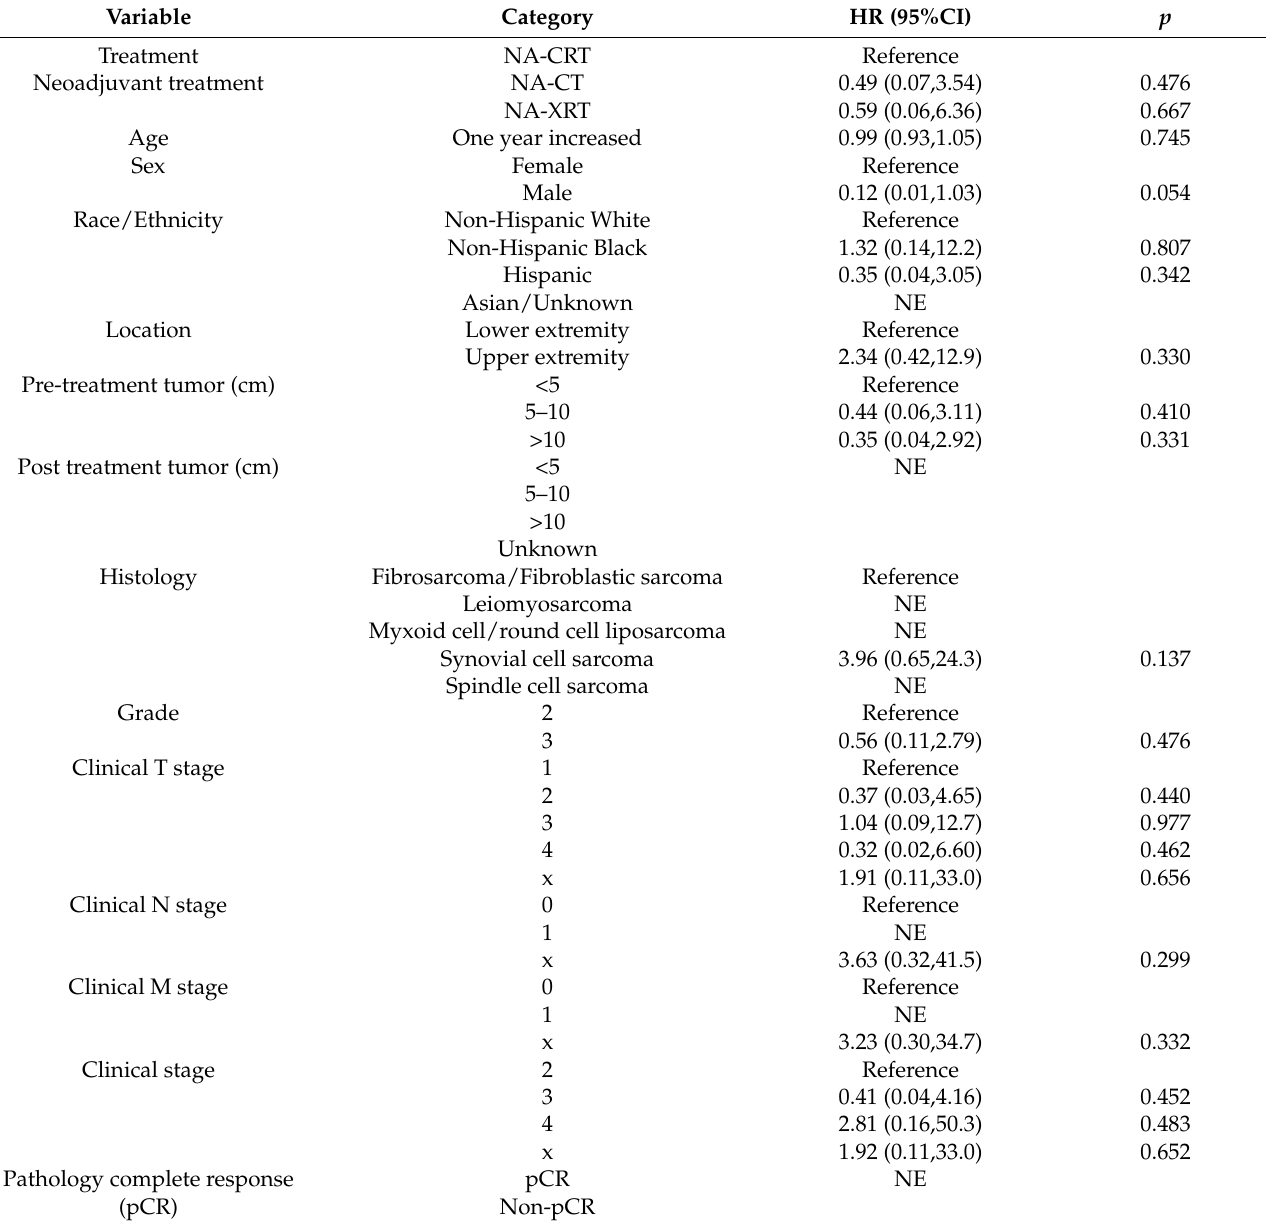
Table 4. Univariate Cox models for